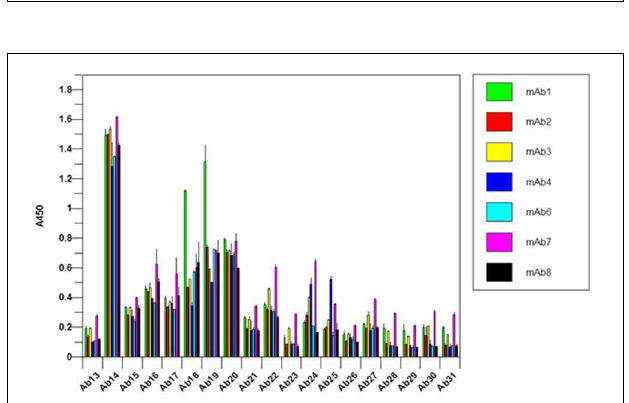
FIGURE 7 | Three-dimensional assignment of changes detected with the antibody array ELISA. Vector NTI Express software from Life technology was used to display the mAb three-dimensional structure based on the information from the protein structure database. The fragment highlighted in yellow is one representative peptide that was used to raise the specific antibody. Epitope exposure changes detected by this antibody therefore, could be assigned to this specific region because the high specificity of the antibodies generated.